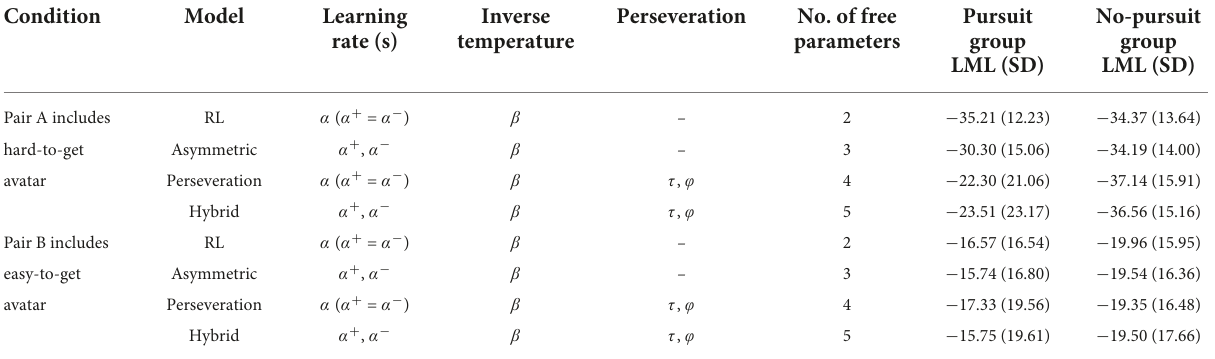
TABLE 2 Models and model selection results in each